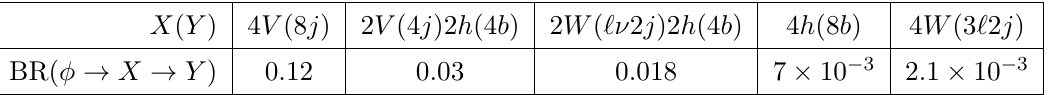
Table 2. A selection of branching ratios leading to interesting (cid:12)nal states double singlet production, assuming BR( (cid:30) ! WW ) = 2 BR( (cid:30) ! ZZ ) = 2 BR( (cid:30) ! hh ) =